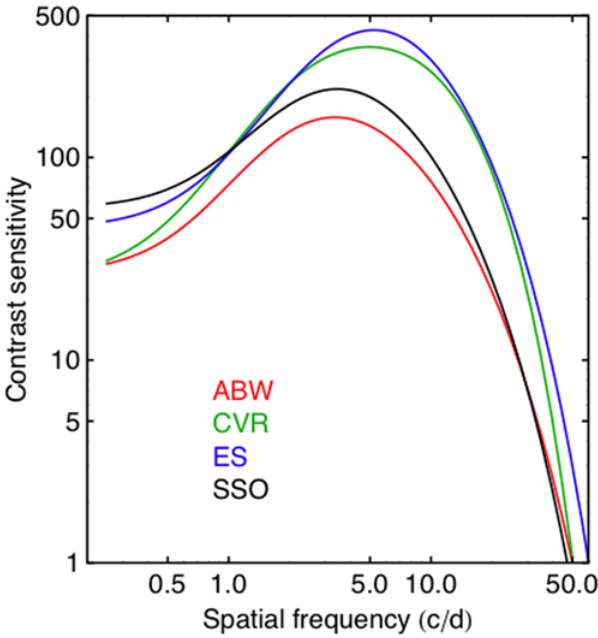
Figure 16. Threshold range as a function of contrast for ten aircraft. Threshold range is the largest distance at which an aircraft can be seen. Dashed lines have slope= K . These results depend upon a particular set of lighting conditions.